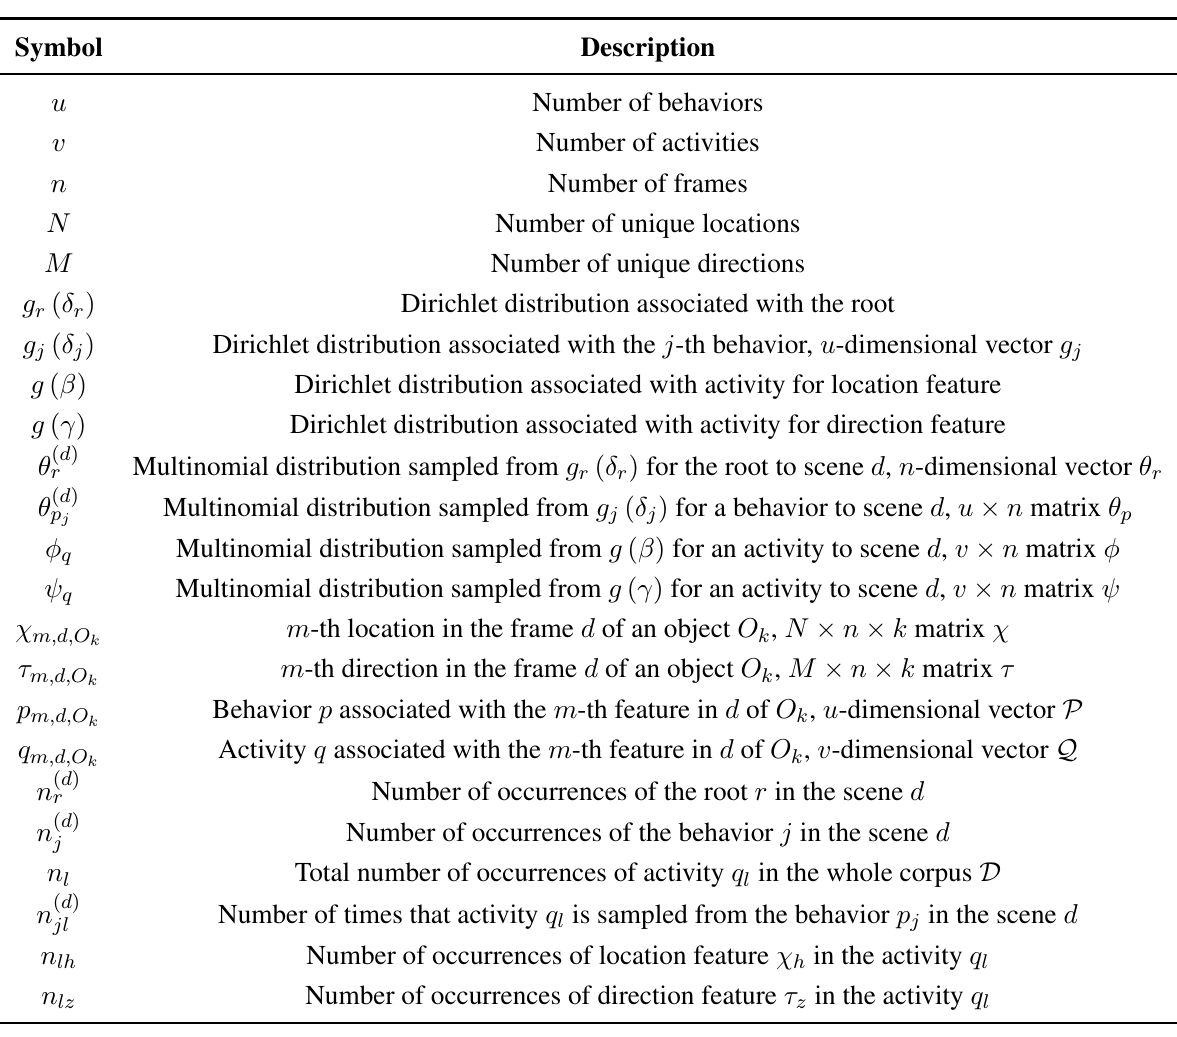
Figure 3. Pachinko allocation model: ( a ) hierarchical topic model ( b ) graphic model. Table 1. Notations used in the pachinko allocation model (PAM)